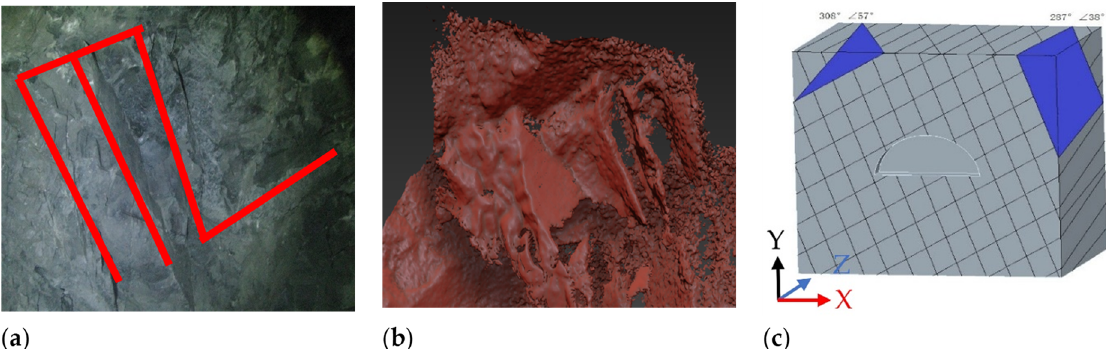
Figure 4. Monitoring section DK 152 + 847–DK 152 + 875 structural surface information: ( a ) visible light photo of the rock wall; ( b ) 3D scan of the rock wall; ( c ) geometric model.